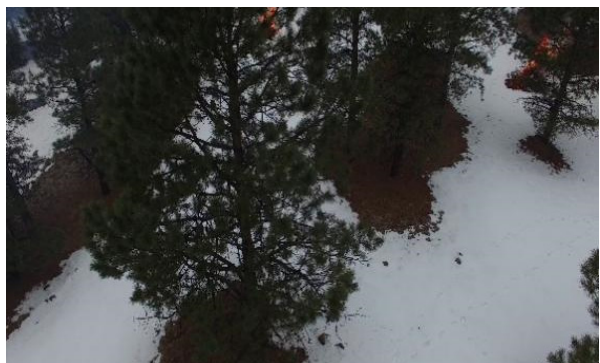
Figure 13. Result detected with YOLO.